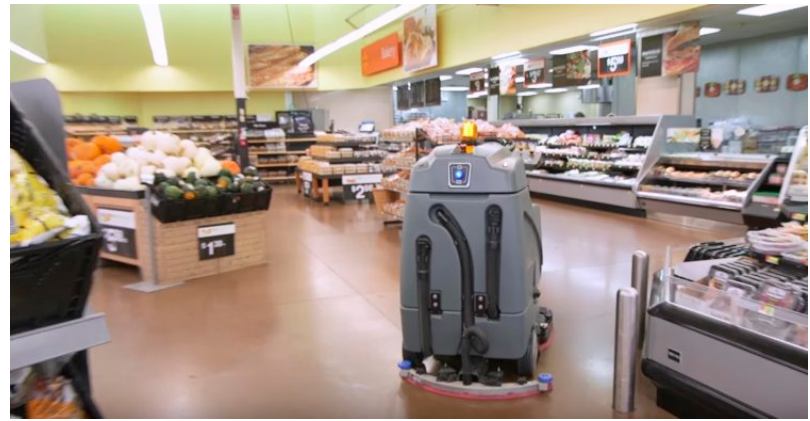
Figure 2. A cleaning robot for using Coverage Path Planning in Big C supermarket.